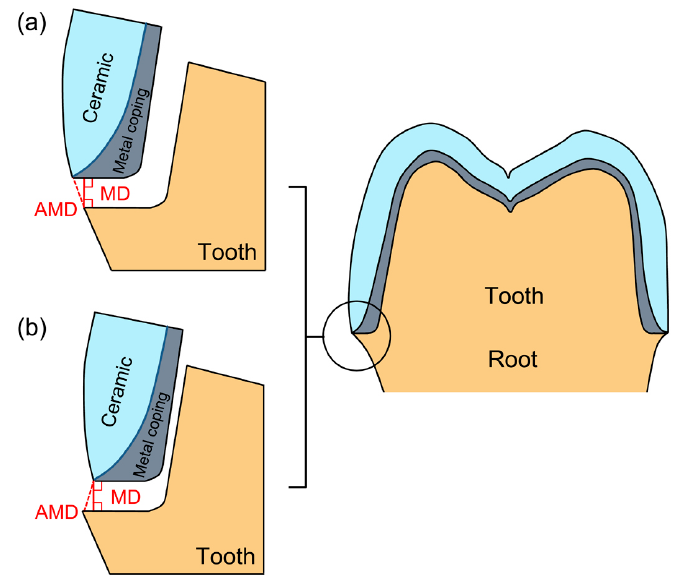
Figure 1. Schematic diagram of dental metal-ceramic crown showing ( a ) over-extended and ( b ) under-extended margins (MD: marginal discrepancy; AMD: absolute marginal discrepancy).